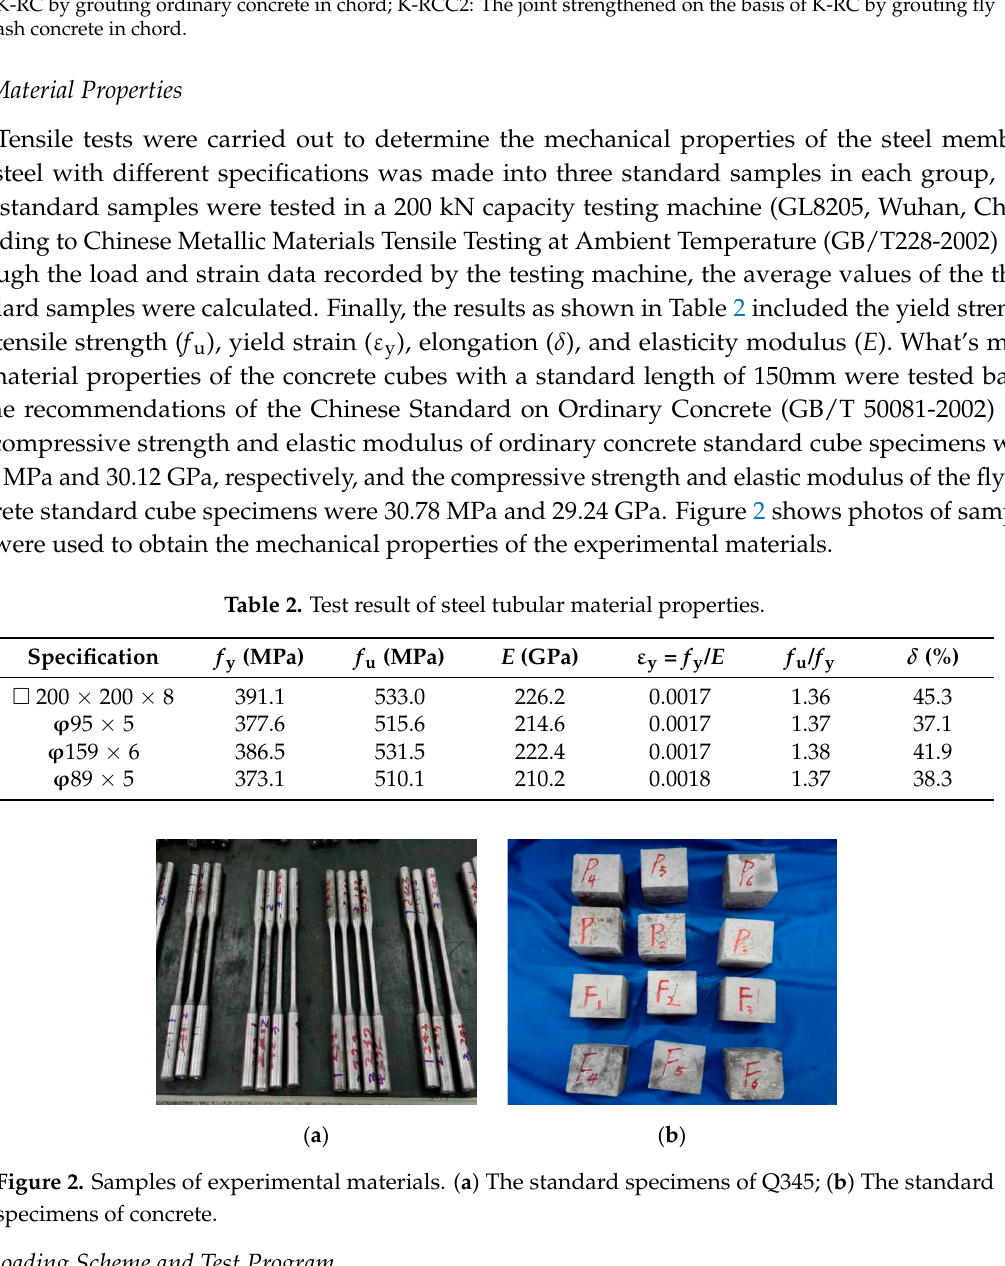
Table 1. Geometric parameters of specimens.